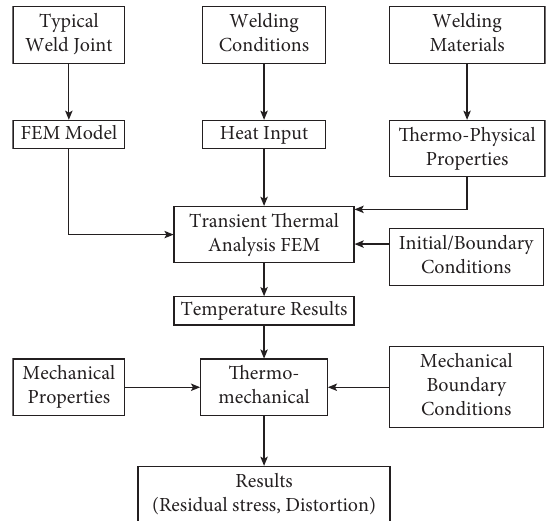
Figure 1: Overview of the thermo-elastic-plastic FEM analysis procedure.